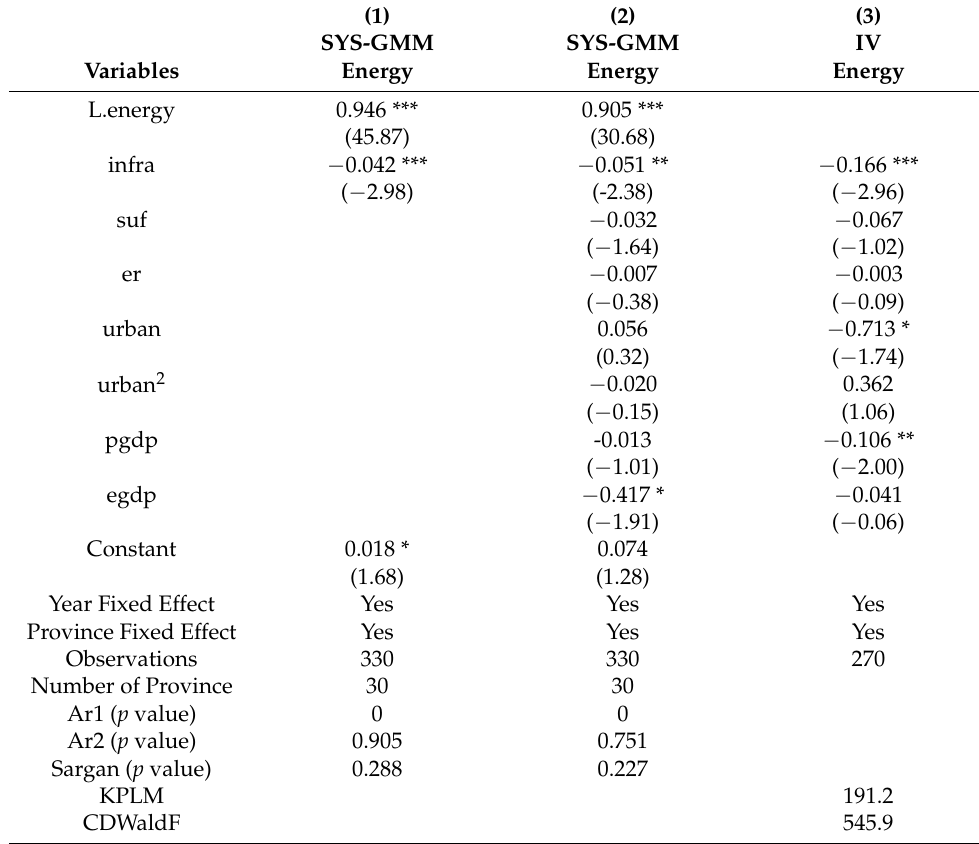
Table 5. Robustness test of NDI for regional energy